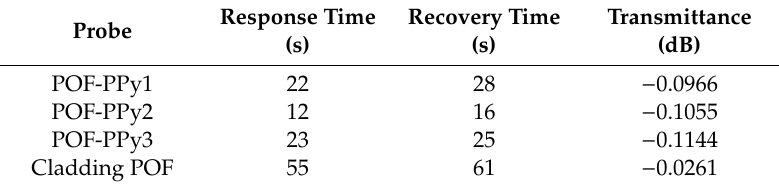
Table 2. Comparison between the three POF-PPy sensors and the cladding POF taper sensor with PPy2